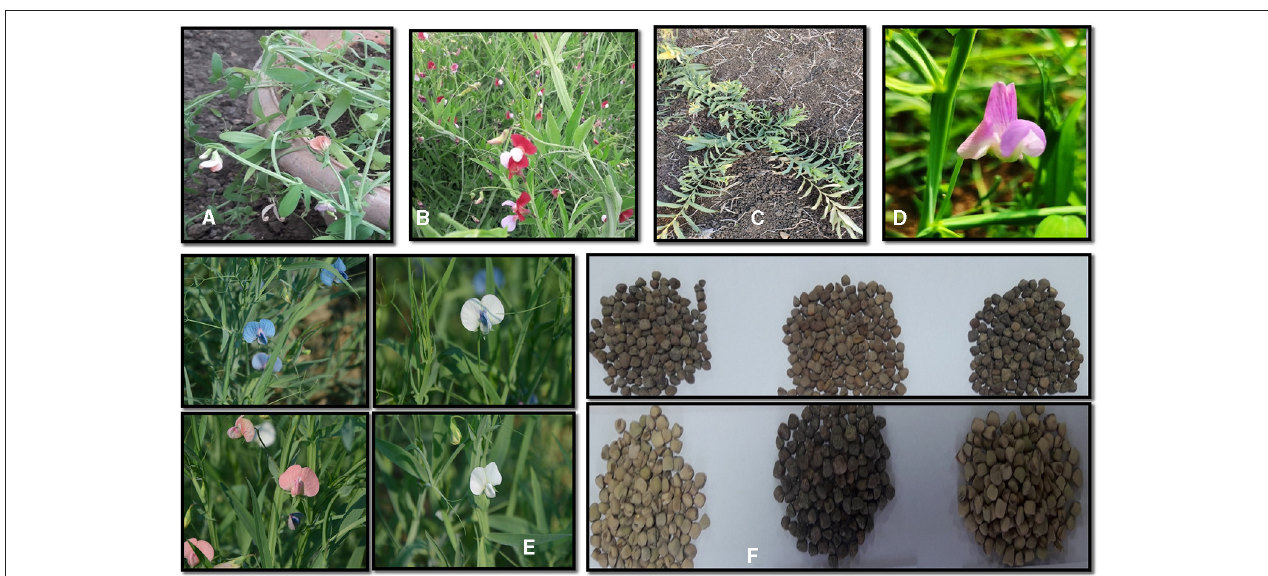
FIGURE 1 | Morphological variation in Crop Wild Relatives (CWR) as well as cultivated species of Lathyrus . (A) Variation in flower color of L. cicera . (B) Variation in flower color of L. articulatus . (C) Morphological variation in L. ochrus . (D) Variation in flower color of L. inconspicuous . (E) Morphological variation in flower color among Lathyrus sativus L. (F) Variation in seed coat color and shape among Lathyrus sativus